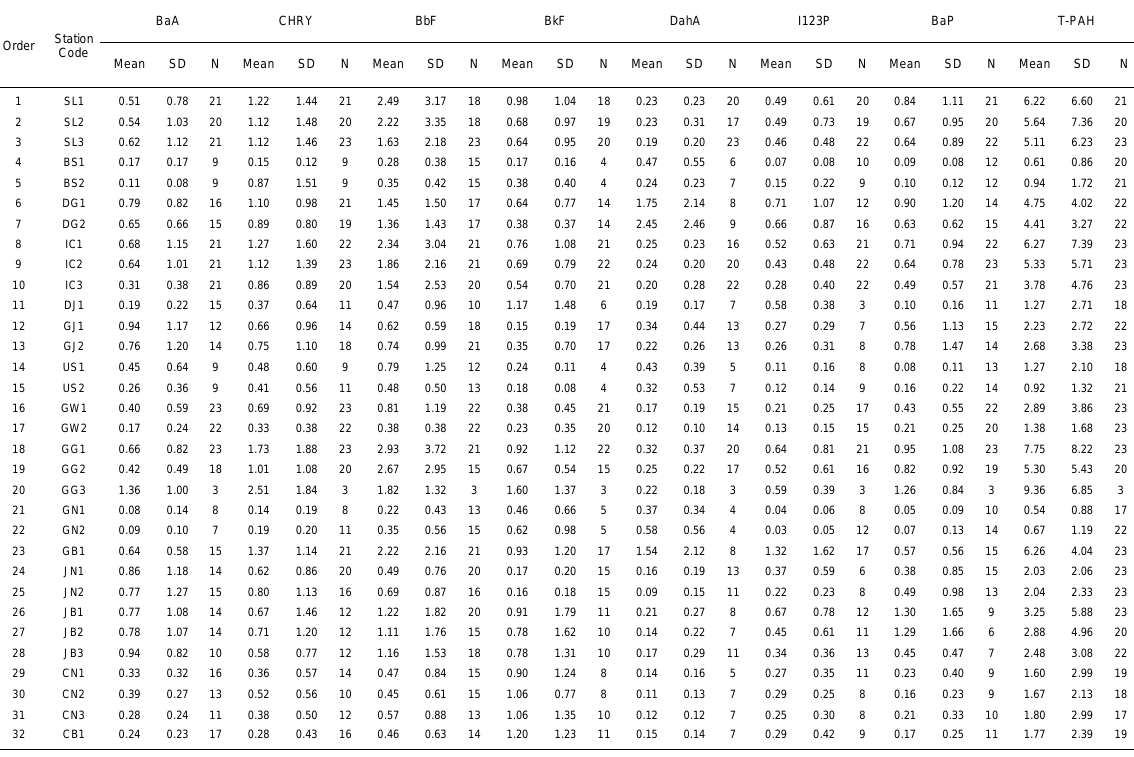
Study Period (All Units in ng m – 3